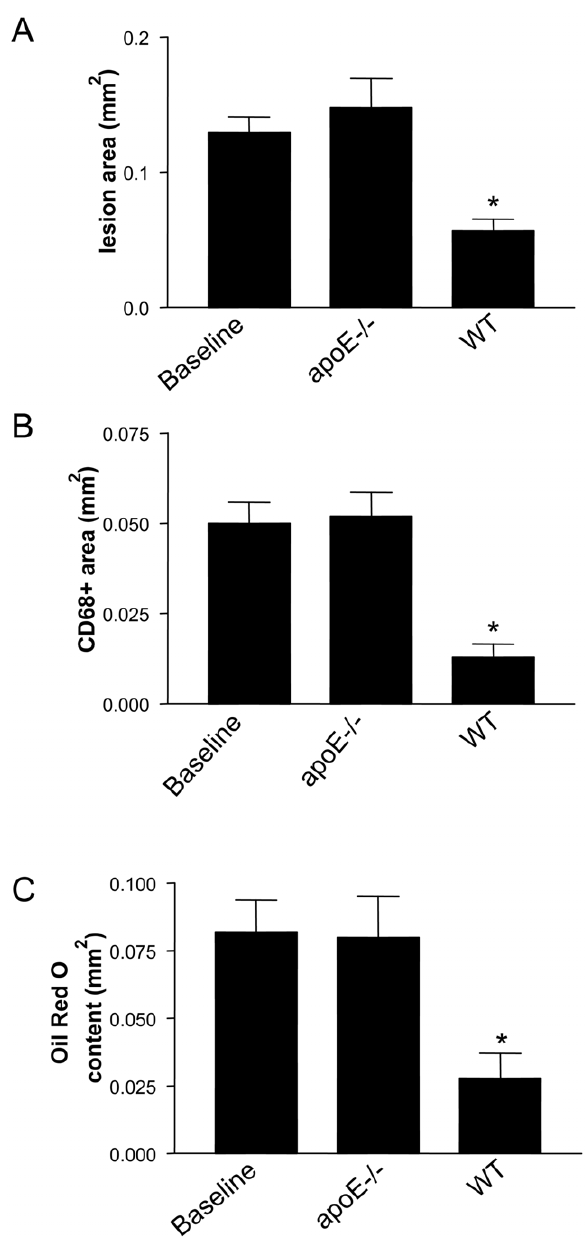
Figure 1. Transfer of plaques to a normolipidemic plasma environment decreases their size and reduces their burden of CD68 + cells and cholesteryl esters. Transplantation experiments were performed as described in Methods. Reversal of dyslipidemia (WT recipient) decreases plaque size (A) and CD68 + cell content (B) but continued dyslipidemia (apoE 2 / 2 ) does not. Cholesteryl ester content was estimated by Oil Red O staining, which showed a decrease when the recipient was a WT mouse but not an apoE 2 / 2 mouse (C). The symbol * corresponds to statistical significance, p , 0.05, when compared to donor apoE 2 / 2 mice